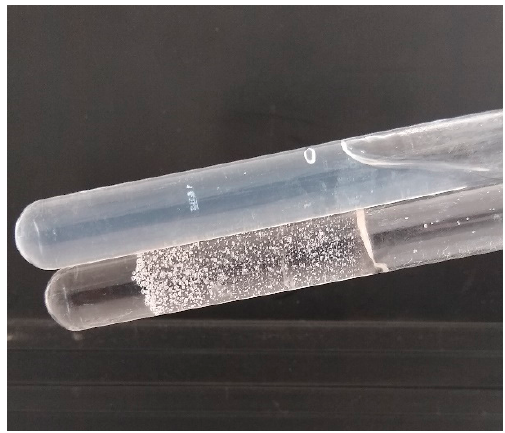
Figure 14. Solution before ( top ) and 30 min after addition of 17.9 M H 2 SO 4 ( bottom ).